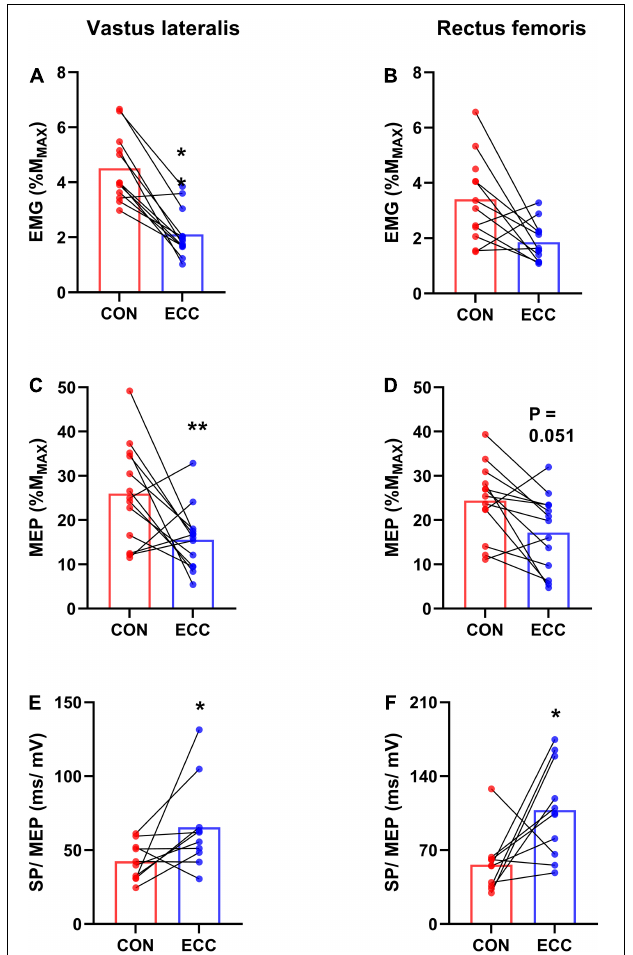
FIGURE 4 | Corticospinal excitability and relative silent period. For each session (concentric—CON—or eccentric—ECC—cycling), this figure illustrates the average (mean of data from the onset and end of exercise) background EMG (A,B) , motor-evoked potential (MEP) amplitude (C,D) and the average ratio between silent period duration and MEP amplitude (SP/MEP) (E,F) for the vastus lateralis and rectus femoris muscles. *Indicates a difference between CON and ECC; one sign means P < 0.05; ** means P < 0.01.